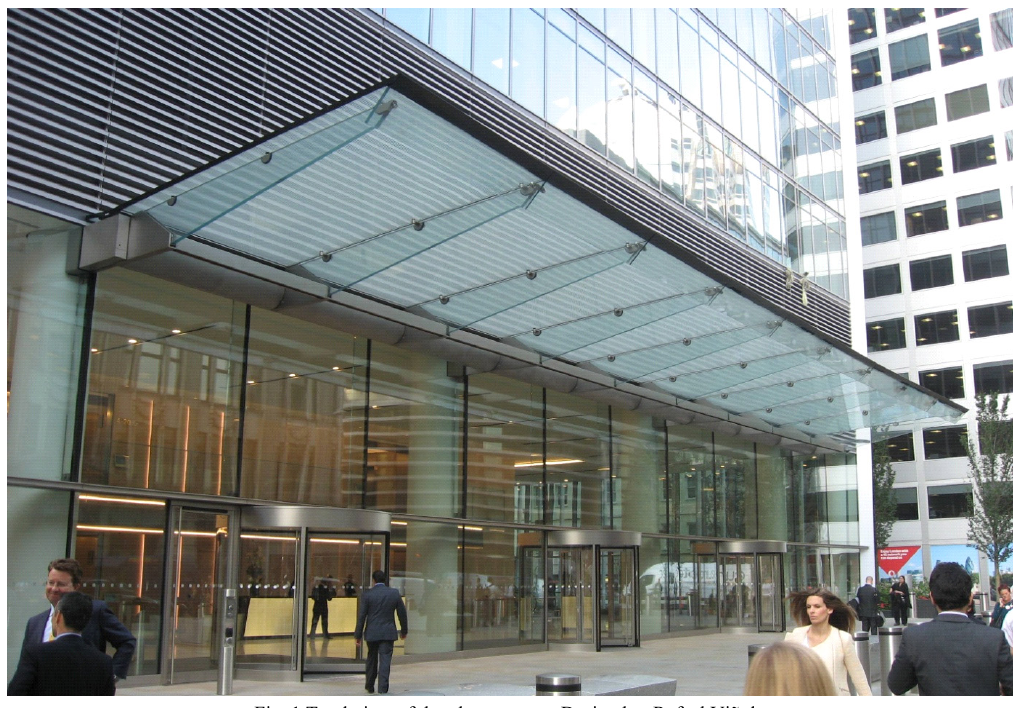
Fig. 1 Total view of the glass canopy, Design by: Rafael